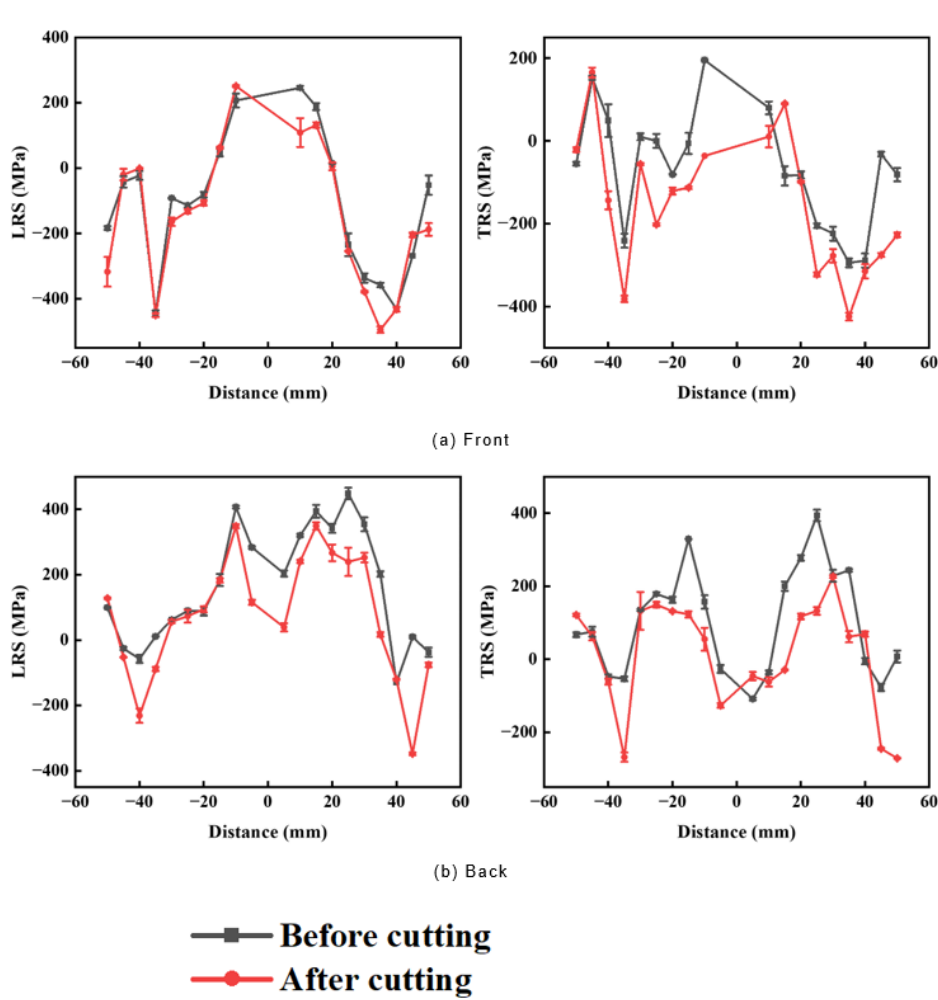
Figure 5. Residual stress distribution of #1 specimen before and after cutting. ( a ) Front; ( b ) Back. After the residual height was cut, the residual stress of all seven groups of the sam- ples decreased.